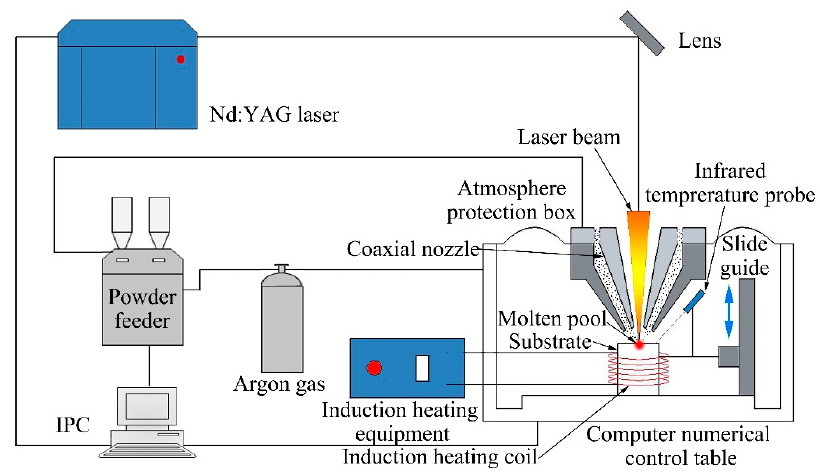
Figure 1. Schematic of the forming process of laser cladding deposition (LCD).